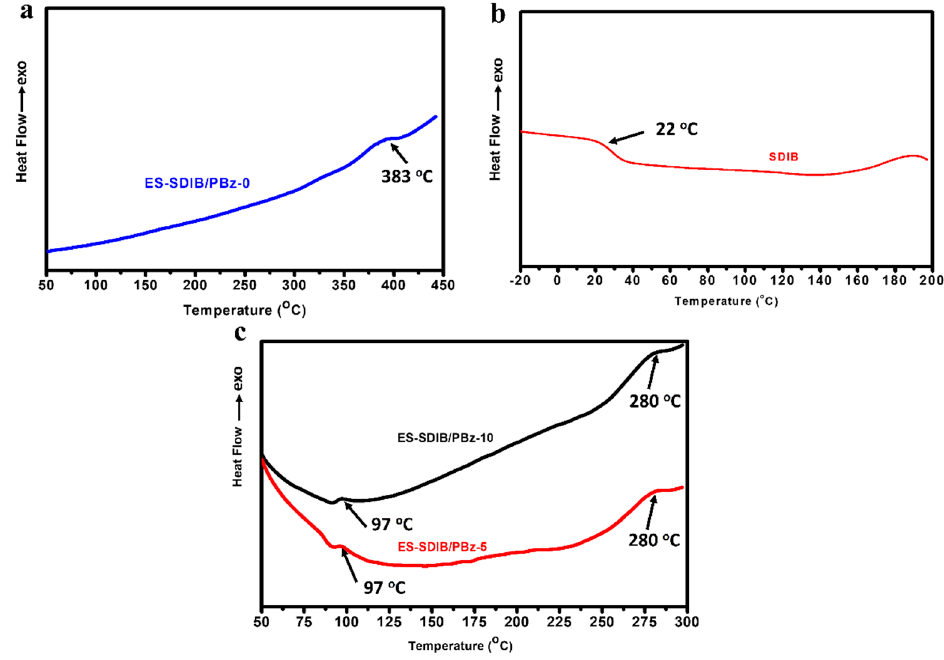
Figure 10. Differential scanning calorimetry (DSC) curves of ( a ) ES ‐ SDIB/PBz ‐ 0 (pure PBz); ( b ) pure SDIB; and ( c ) ES ‐ SDIB/PBz ‐ 5 and ES ‐ SDIB/PBz ‐ 10 with the new glass transition temperatures.